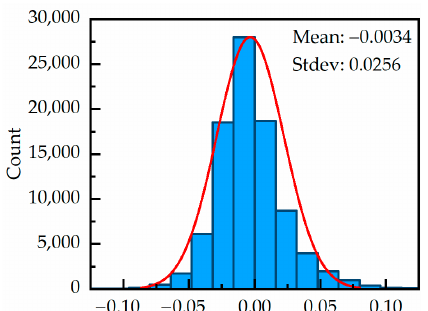
Figure 7. The scatterplot of the restored reflectance versus the real reflectance of the 90,000 snow cover samples in the SWIR band.